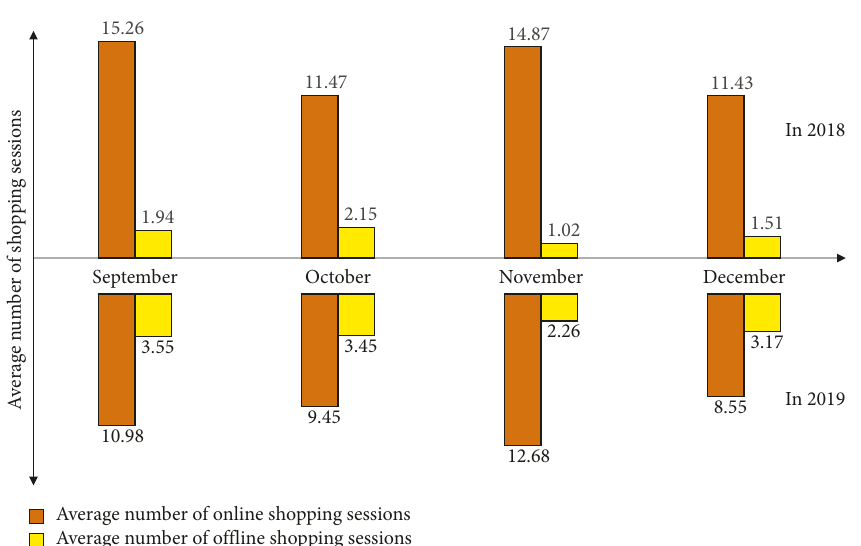
Figure 6: The average number of online and offline